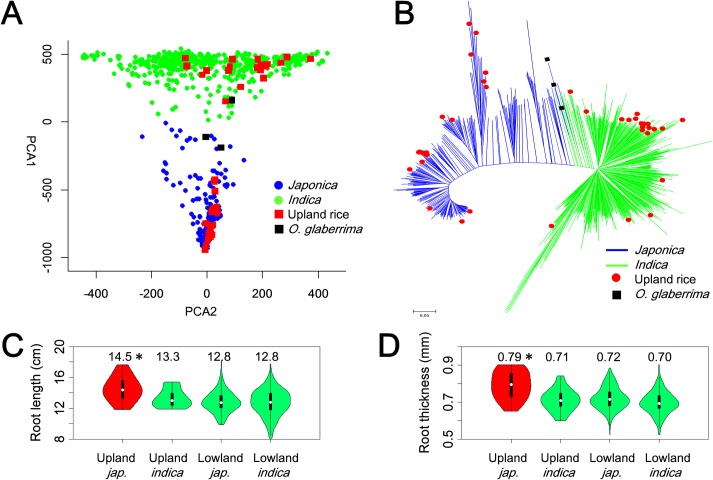
Population structure of 795 O. sativa (rice) accessions, phenotypic diversity in root traits.(A) Principal component (PC) plots of different ecotypes and subpopulations; and (B) neighbor-joining tree of all accessions and distribution of upland rice accessions in the N-J tree. PC analysis was performed using 3.3 million SNPs with missing data rates ≤ 50% and minor allele frequency ≥ 5%. N-J tree was constructed using 54,853 SNPs evenly distributed throughout the genome. Distribution of (C) root length and (D) root thickness among different rice ecotypes. Y-axes show the median (white point), 95% of confidence intervals (black bars) and range (colored shapes) of the trait phenotypes. X-axes indicate different ecotypes, ordered by upland japonica, upland indica, lowland japonica and lowland indica. Numbers above violins are mean phenotypic values of different populations. Ecotypes colored red with * were significantly higher than those colored green (P < 0.05 detected by one-way ANOVA).